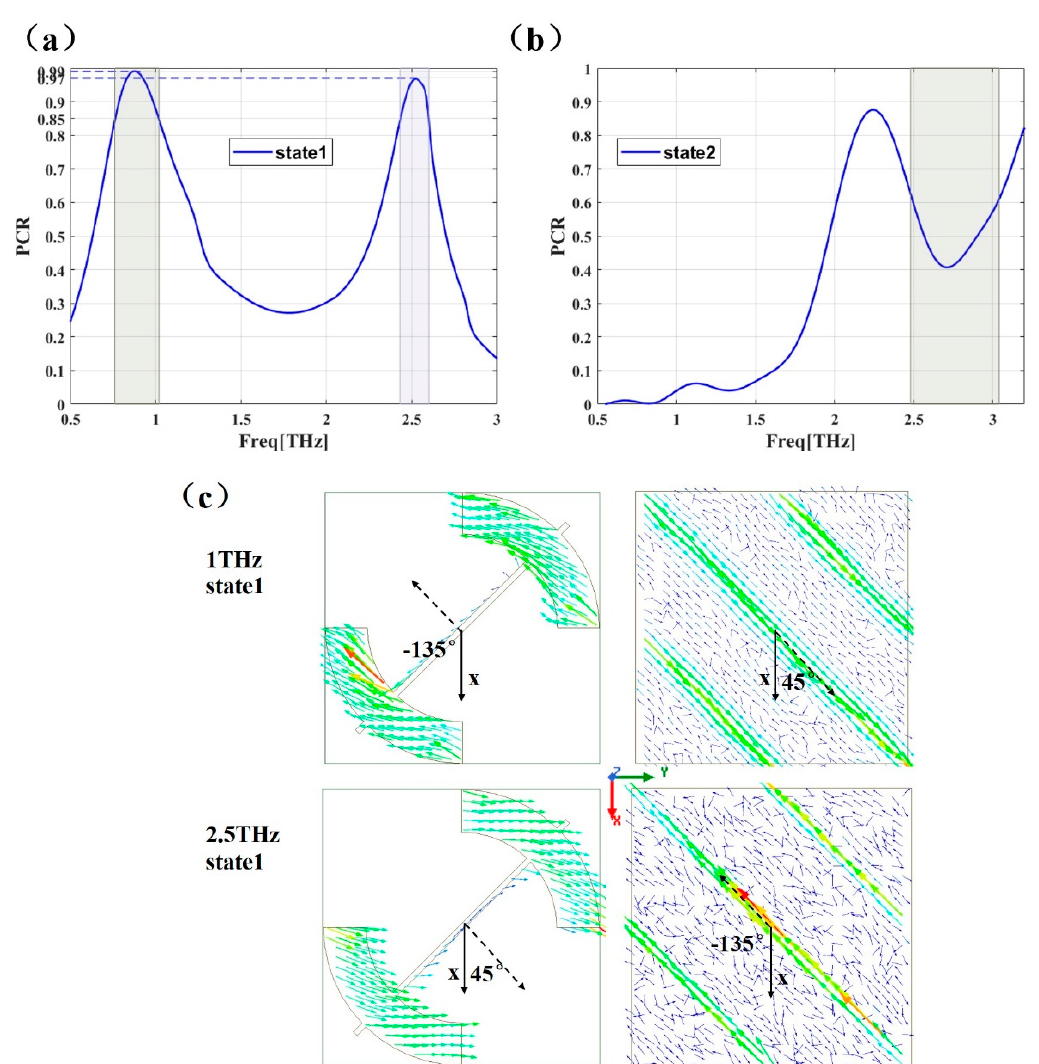
Figure 5. Polarization conversion ratio of PCM unit at state 1 (0.0 eV) ( a ) and state 2 (0.5 eV) ( b ). ( c ): The surface current distribution on the top layer (1st column) and the bottom layer (2nd column) of the PCM unit in state 1, the dashed arrows represent the direction of surface